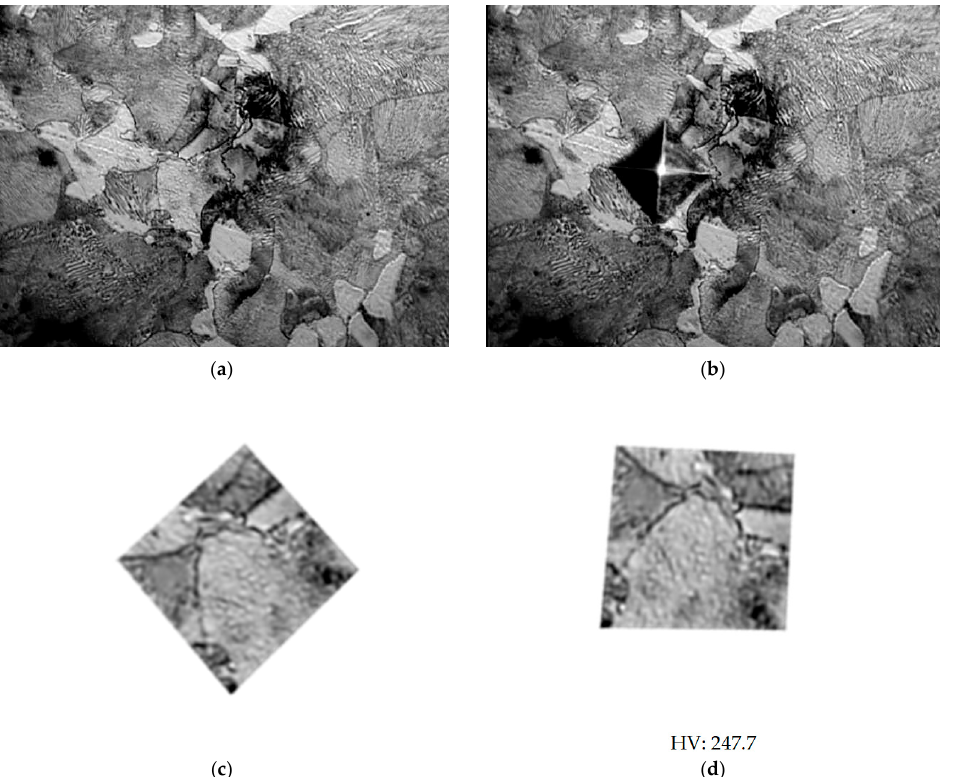
Figure 4. The training sample generation process applied by this study. ( a ) The original image of a specimen captured by a microscope; ( b ) the image of the same specimen after the Vickers hardness test; ( c ) the indentation extracted by the image processing technology; ( d ) the final rotated image and its corresponding HV.